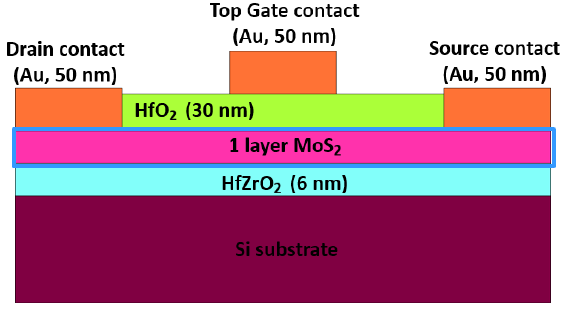
Figure 4. COMSOL schematic view of the ferroelectric-metal field-effect transistor (FEM-FET) structure.